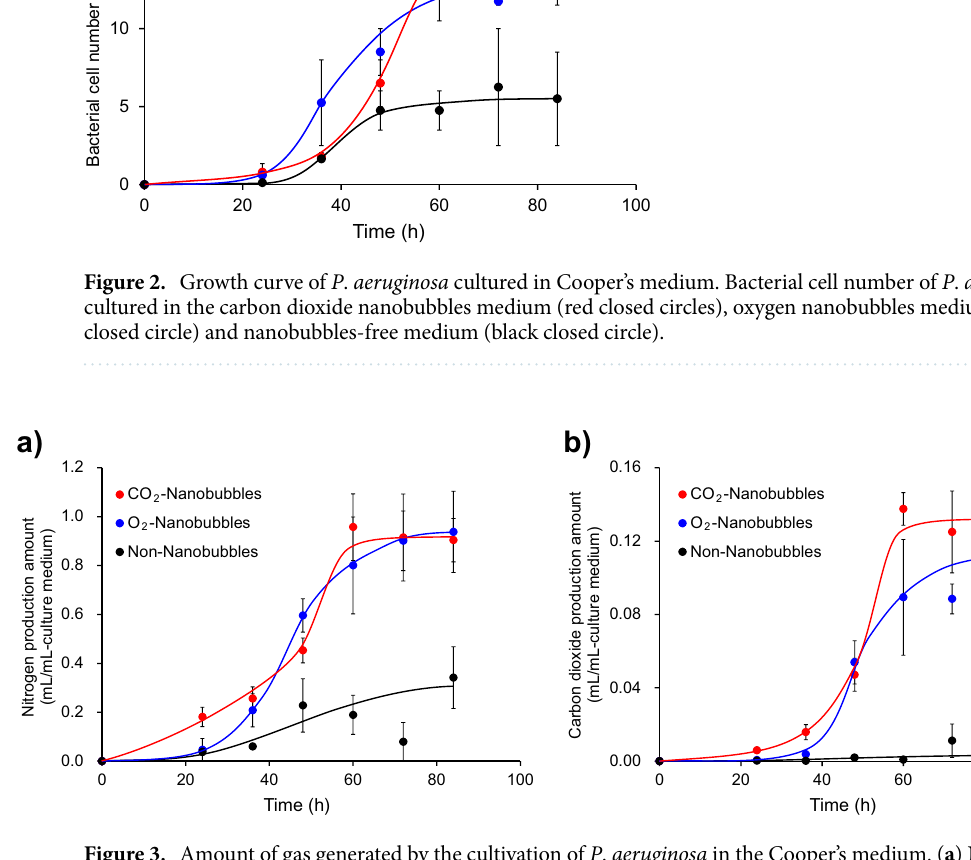
Figure 3. Amount of gas generated by the cultivation of P . aeruginosa in the Cooper’s medium. ( a ) Nitrogen production amount in the carbon dioxide nanobubbles medium (red closed circle), oxygen nanobubbles medium (blue closed circle) and nanobubbles-free medium (black closed circle). ( b ) Carbon dioxide production amount in the carbon dioxide nanobubbles medium (red closed circle), oxygen nanobubbles medium (blue closed circle) and nanobubbles-free medium (black closed